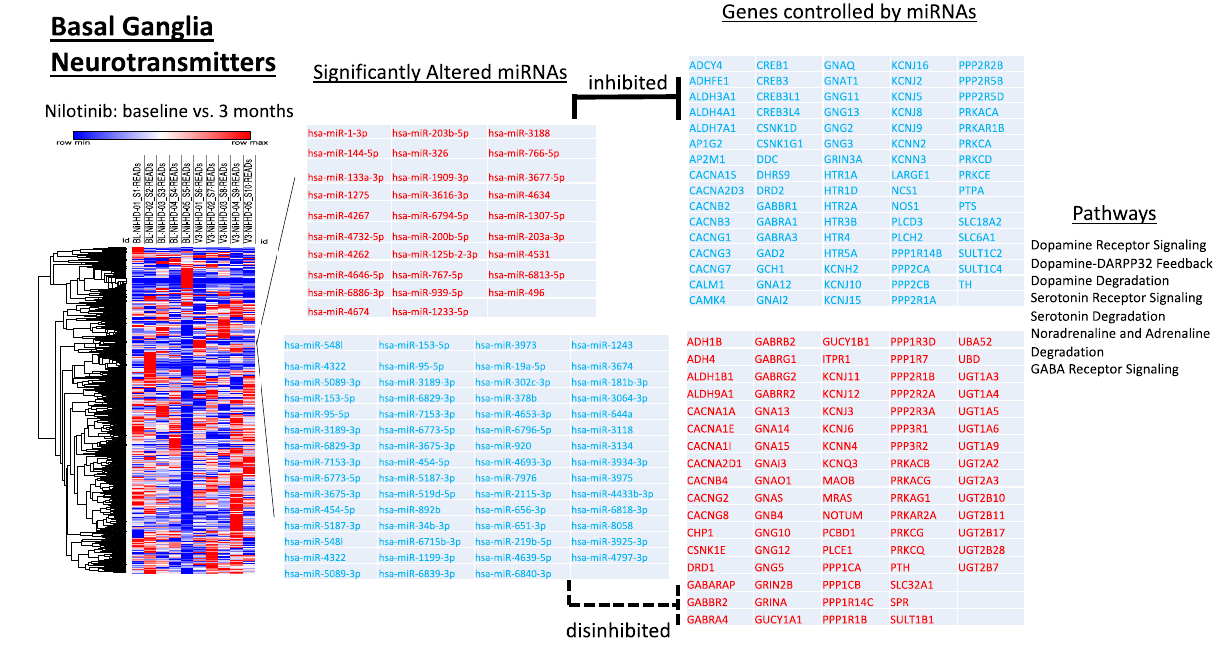
Figure 3. miRNAs target genes associated basal ganglia neurotransmitters. Gene ontology analysis revealed 29 upregulated and 59 downregulated miRNAs that target 162 genes experimentally observed to be associated with dopamine, serotonin, noradrenaline, adrenaline, and GABA signaling.